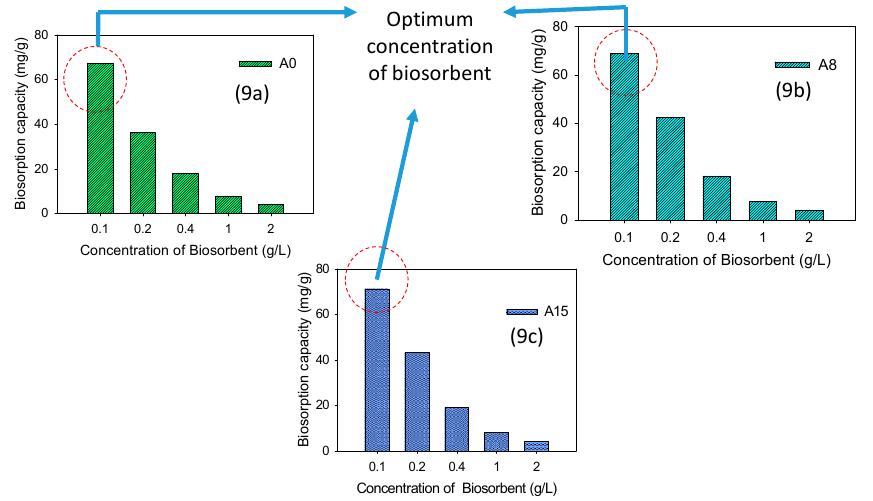
Figure 9. Effect of biosorbent concentration on sorption efficiency of Cd 2+ onto dried biosorbent of Aphanothece sp. for ( a ) adsorbent A0 (CO 2 enrichment of 0.04%), ( b ) adsorbent A8 (CO 2 enrichment of 8%) and ( c ) adsorbent A15 (CO 2 enrichment of 15%) (C 0 = 7.99 mg/L, t contacts = 60 min, T = 30 °C).